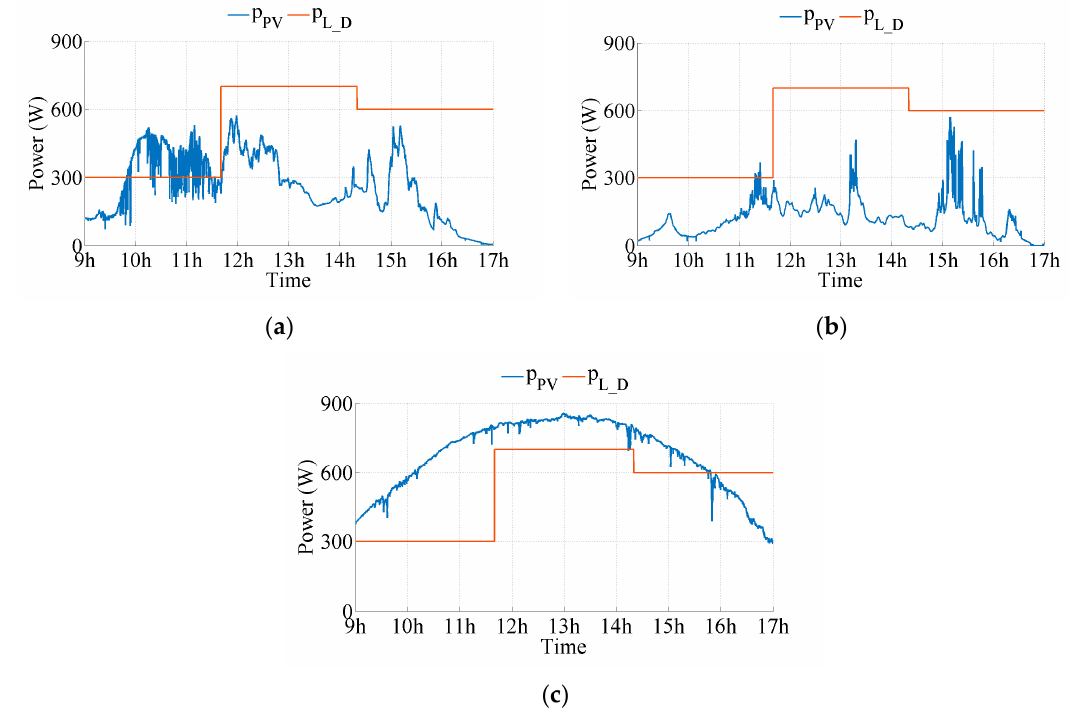
Figure 9. PV and load power profiles: ( a ) PV power profile of 13 November 2014; ( b ) PV power profile of 27 January 2015; ( c ) PV power profile of 12 March 2015.